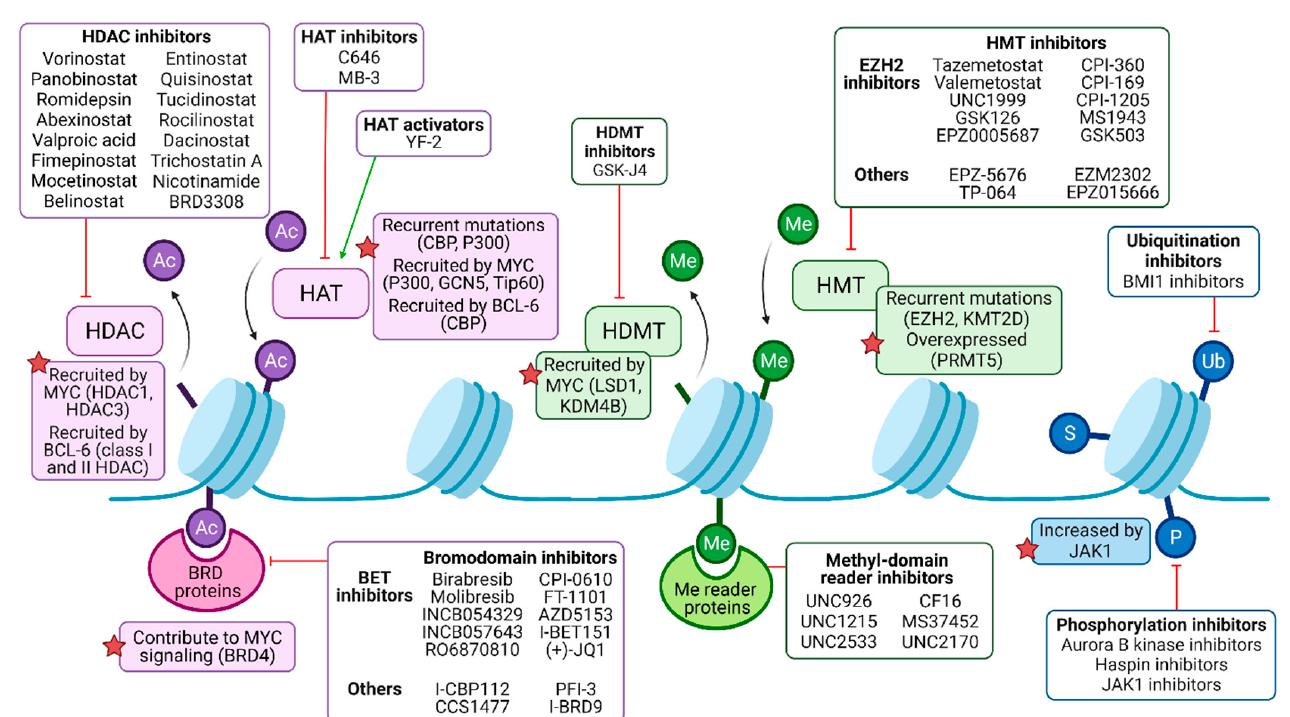
Figure 2. Pharmacological modulation of deregulated histone modifiers in B-NHL. Histone acetylation (Ac) is catalyzed by histone acetyltransferases (HATs), frequently recruited by oncogenic drivers MYC and/or BCL-6 in malignant B cells, and may be targeted by either activators or inhibitors. Histone deacetylases (HDACs) mediate deacetylation and are the target of numerous inhibitory drugs, as some of them present recurrent mutations and B-NHL and may be recruited by MYC and/or BCL-6 as well. Bromodomain (BRD)-containing proteins can bind to acetylated residues, enhancing oncogenic signaling (such as MYC program, in the case of BRD4), and can be targeted by pan or isoform-specific inhibitors. Methylation (Me) is regulated by histone methyltransferases (HMTs) and histone demethylases (HDMTs). HMTs are common targets of epigenetic drugs, especially the EZH2 subunit of the polycomb repressor complex 2 (PRC2), since it is recurrently mutated in B-NHL. HDMT inhibitors can partially counteract MYC signaling, among other effects. Me domain